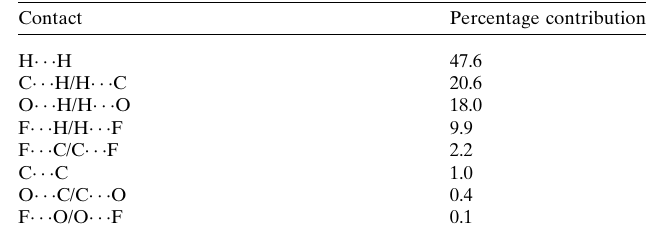
Table 2 Summary of short interatomic contacts (A˚ ) in the title salt 1 . Contact